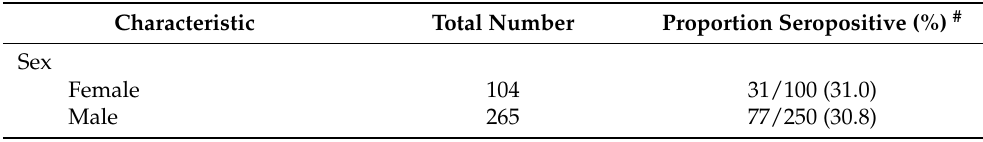
Figure 1. Locations of abattoir facilities sampled in the abattoir survey, South Africa, 2018. Table 1. Characteristics and Coxiella burnetii seropositivity of participants in the abattoir survey, South Africa,